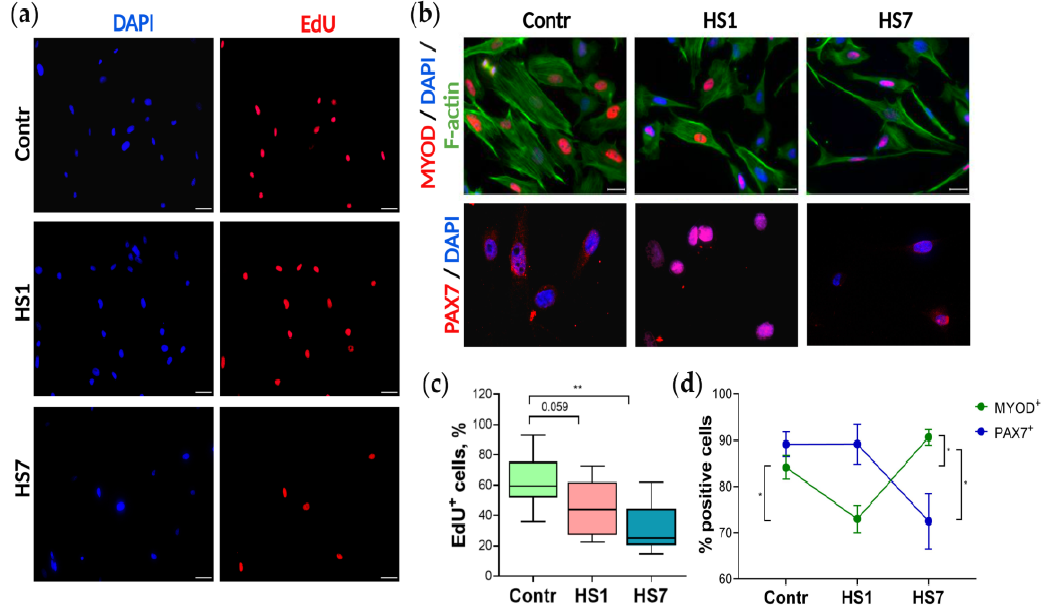
Figure 2. Functional properties of myoblasts cultured for 24 h after purification: ( a ) Myoblast proliferative activity analysis by EdU incorporation; EdU + cells are shown in red; nuclei are shown in blue. ( b ) Immunostaining: MYOD and PAX7 positive cells are shown in red; nuclei are shown in blue; F-actin is shown in green; scale bar = 20 µm. ( c ) The percentage of EdU + cells estimated in 2 independent experiments; n > 200, ** p < 0.01. ( d ) The percentage of MYOD positive cells increases in the HS7 cultures, in contrast to PAX7 positive cells; n > 200, * p < 0.05.